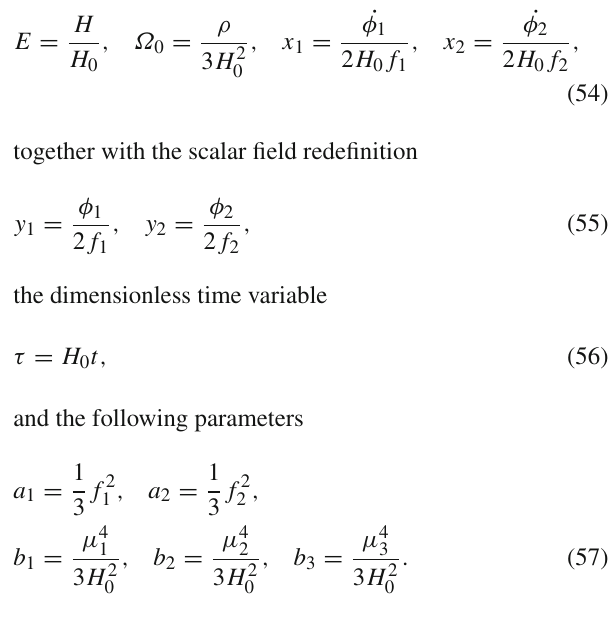
) with the local minimum of Fig. 2 Surface V (φ 1 ,φ 2 )/( 3 H 2 0 ) at φ ∗ := (φ ,φ ) = ( 0 . 0614165 , 0 . 572375 ) with V (φ 1 ,φ 2 )/( 3 H 2 1 2 0 = 0 . 682603 (denoted by a red star). The para- minimum value of Λ eff 3 H 2 0 , z ∈ [− 1 , 100 ] metric curve (denoted by a blue line) V (φ 1 ( z ),φ 2 ( z )) 3 H 2 0